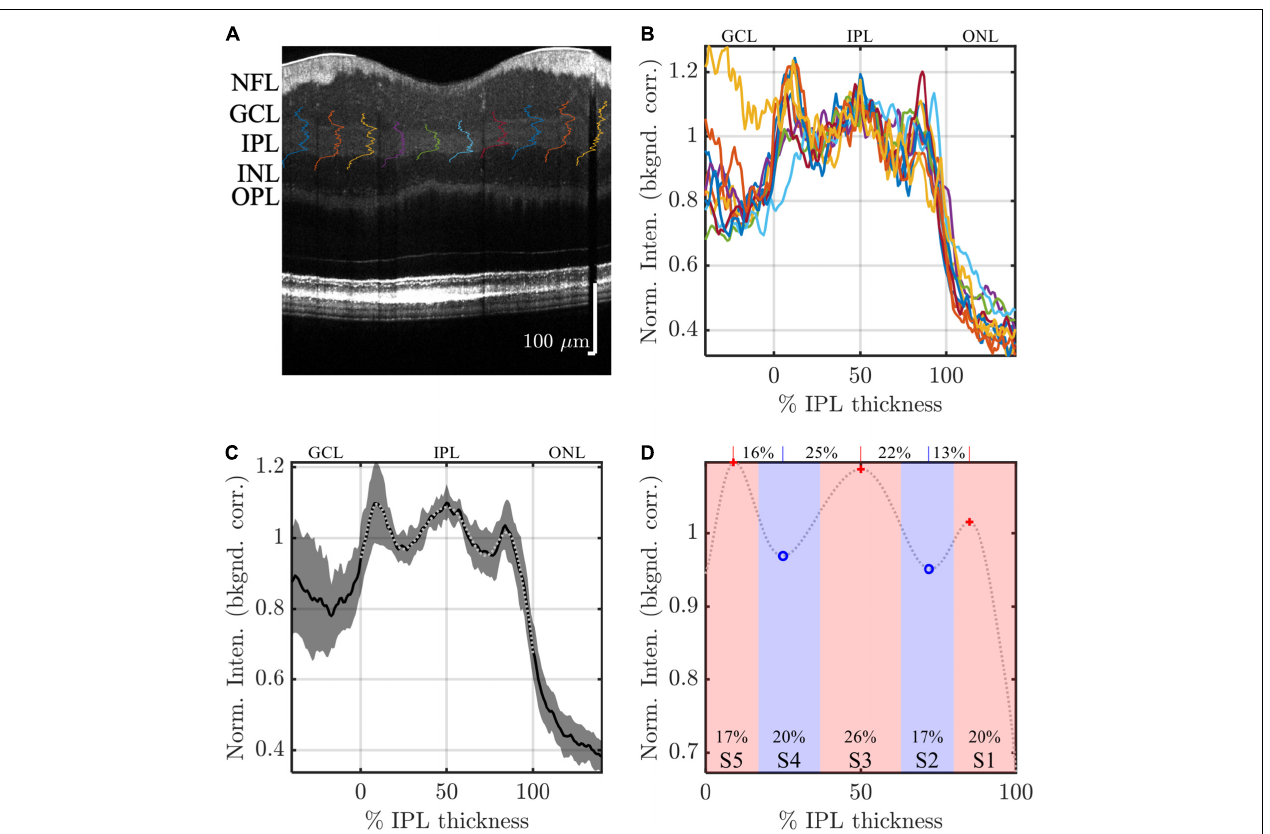
FIGURE 2 | Image analysis: example analysis of IPL strata (S1-S5) in a high quality visible light OCT image. IPL intensity profiles (background corrected, averaged transversally over 1.5 ◦ , and normalized so the average IPL intensity is 1. are displayed across the image (A) and also plotted versus % IPL thickness (B) . (C) Average IPL profile, excluding segments with an IPL thickness below 24 microns, across locations (mean ± SD) shows a stereotyped pattern with 3 peaks and 2 valleys. A polynomial fit approximates the average profile (light gray dotted line), providing estimates of both peak and valley (extrema) locations (D) . In this example, the reflectivity peak at the center of S3 is broad, separated by 25 and 22% IPL thickness from the nearest inner and outer valleys, respectively, as shown on top of the plot. This broad peak is flanked by relatively narrower peaks at the centers of S1 and S5, which are separated from the nearest inner and outer valleys by only 13 and 16% IPL thickness, respectively. In agreement with this observation, a wider S3 was also noted, where stratum divisions were defined by positions where intensity crossed the midpoint between adjacent extrema (red and blue shading), as shown at the bottom of the